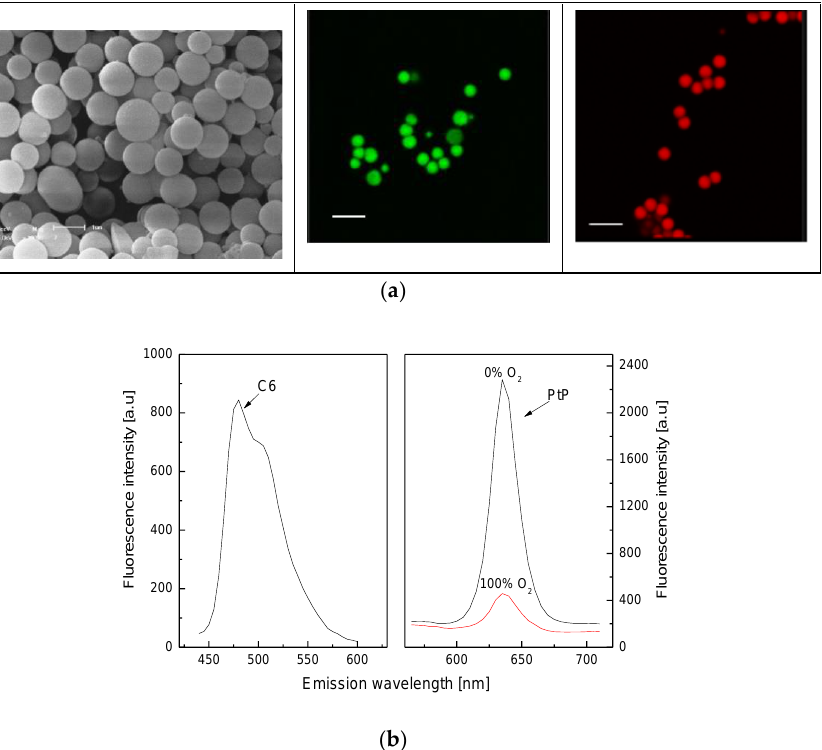
Figure 1. ( a ) SEM image (left) of PS particles with scale bar of 1 µm and fluorescence images of PS@C6 particles (middle) and PS@C6^PtP particles (right) with scale bar of 2 µm; ( b ) fluorescence response of C6 and PtP in PS@C6^PtP membrane to different oxygen concentrations.